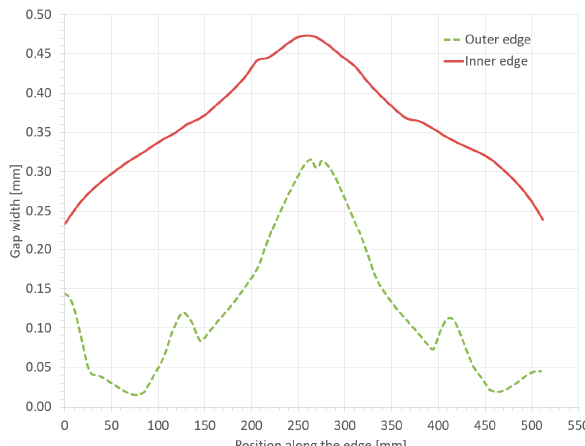
Figure 12. Gap width (for the inner and outer edge) in relation to a position along the edge (the local maxima correspond to ribs on the cover).